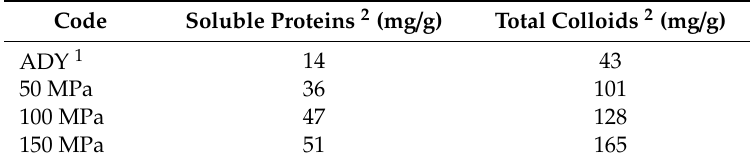
Table 4. Application of HPH (50–150 MPa) to a water suspension of S. bayanus active dry yeast (ADY); e ff ect on the release of proteins and glucidic colloids in wine-like solution. Extracted from Comuzzo et al., 2015—Modified